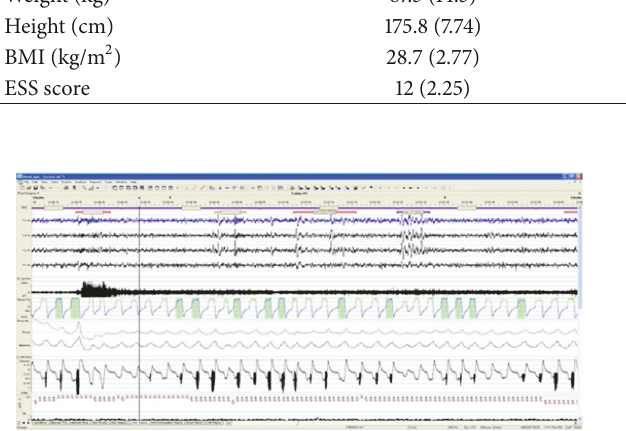
Figure 1: A sample of CAP sequence in the study